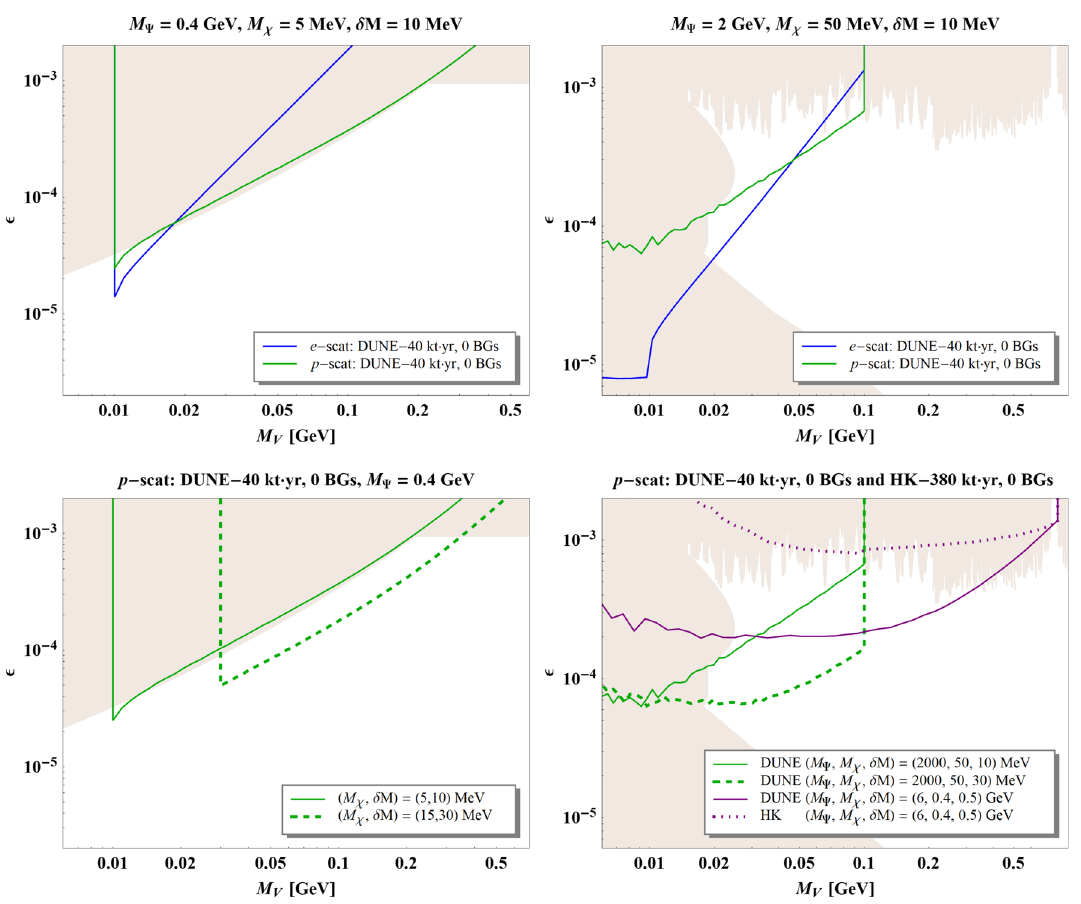
Fig. 21 The experimental sensitivities in terms of reference model parameters M V − (cid:12) for M Ψ = 0 . 4GeV, M χ = 5MeV, and δ M = M χ (cid:5) − M χ = 10MeV (top-left panel) and M Ψ = 2GeV, M χ (cid:5) = 50MeV, and δ M = 10MeV (top-right panel). The left panels are for